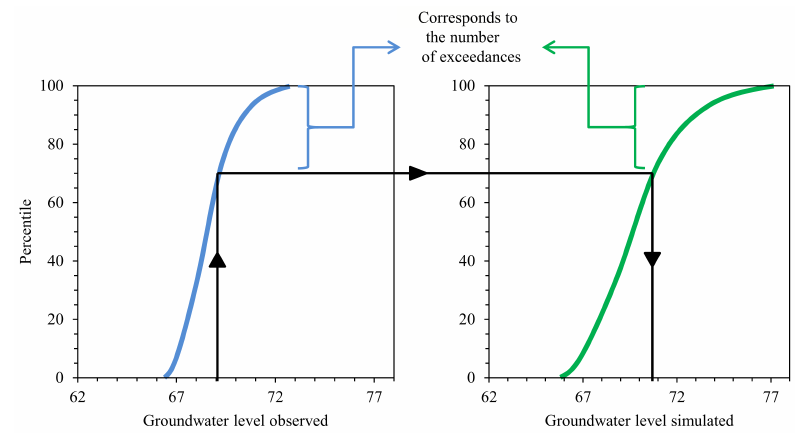
Figure 3. Schematic description of the percentile